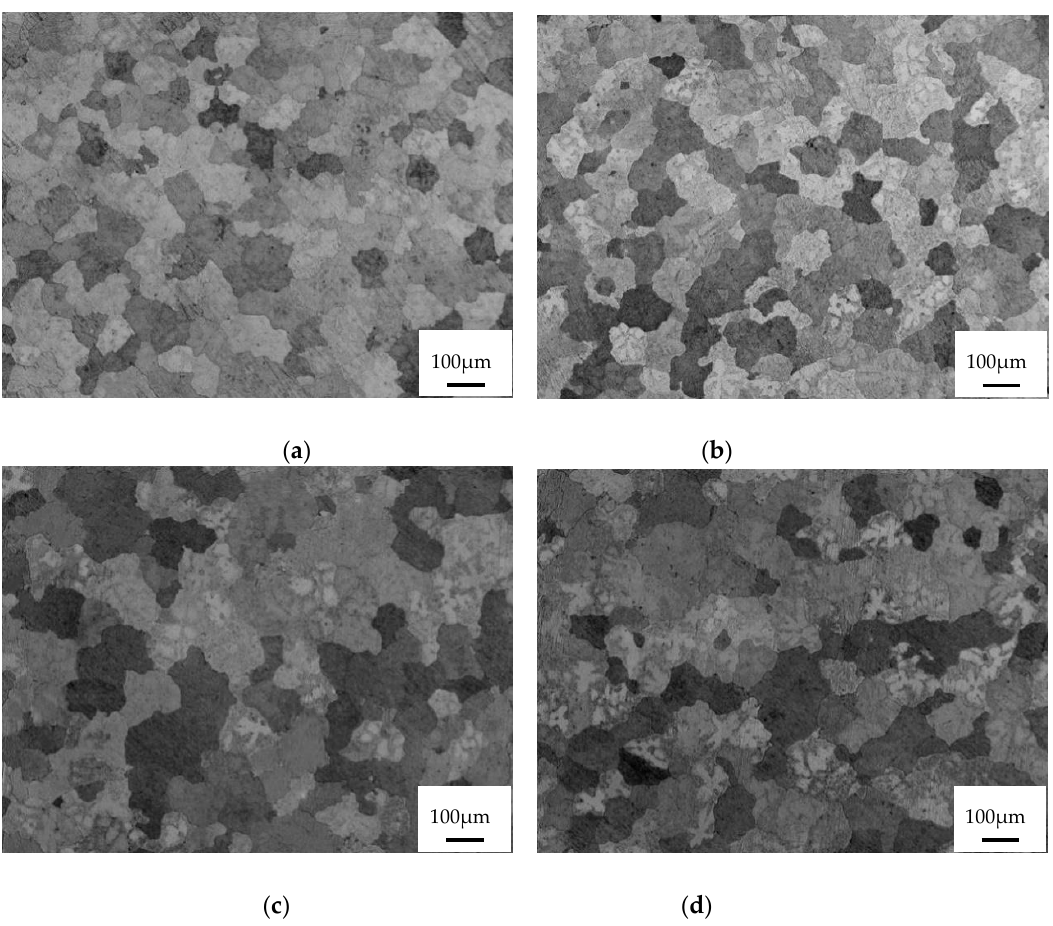
Figure 8. Microstructure of squeeze-cast ZL205A under different ageing time: ( a ) 155 °C × 4 h; ( b ) 155 °C × 6 h; ( c ) 155 °C × 8 h; ( d ) 155 °C × 10 h.